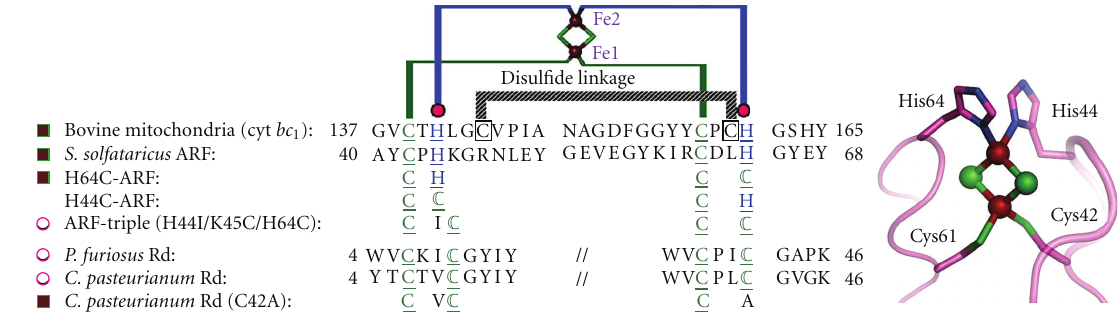
Figure 3: Multiple sequence alignment of the metal-binding sites of selected Rieske-type proteins and rubredoxins (Rd). The cluster-binding motif of S. solfataricus ARF is characteristic of Rieske-type ferredoxins involved in bacterial multicomponent oxygenases, containing two histidyl (blue) and two cysteinyl (green) ligands, and lacks two conserved cysteine residues (black) that serve as the disulfide linkage in high potential, respiratory Rieske proteins [138, 153]. DDBJ-EMBL-GenBank accession codes: bovine mitochondrial cytochrome bc 1 -associated Rieske protein fragment, P13272; S. solfataricus ARF (hypothetical ORF c06009), CAA669492, AB047031; P. furiosus rubredoxin, P24297; C. pasteurianum rubredoxin, P00268. The metal-binding motifs are underlined (left), and the structure of the cluster ligand residues of a bovine mitochondrial Rieske protein domain fragment (PDB code, 1rie.pdb) [145] is shown, but with the S. solfataricus ARF numbering (right). Brown square symbols (left), wild-type or mutant proteins containing a [2Fe-2S] cluster; magenta open circles (left), wild-type or mutant proteins containing a Rd-like, mononuclear (Fe/Zn)